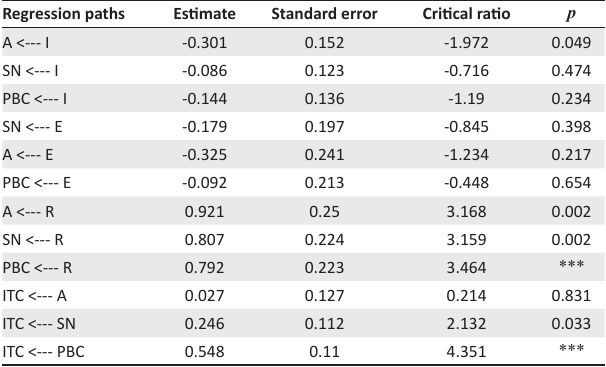
TABLE 2: Standardised regression weights. Regression